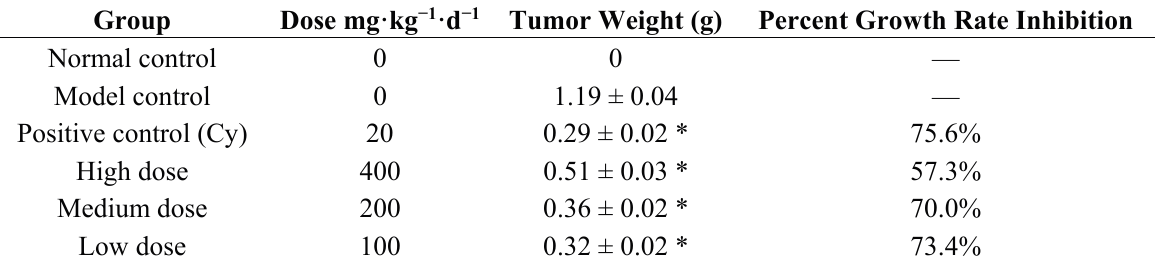
Table 1. Effects of BBP on S180 tumor growth in vivo in mice ( x ± s, n = 10).